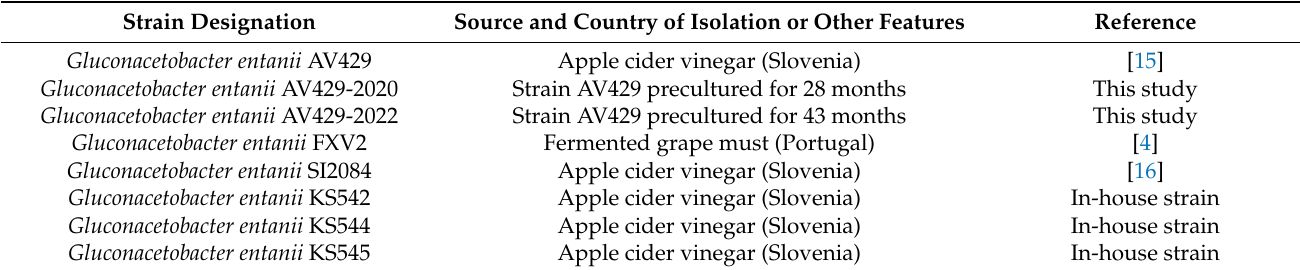
Table 1. List of strains used in the study.